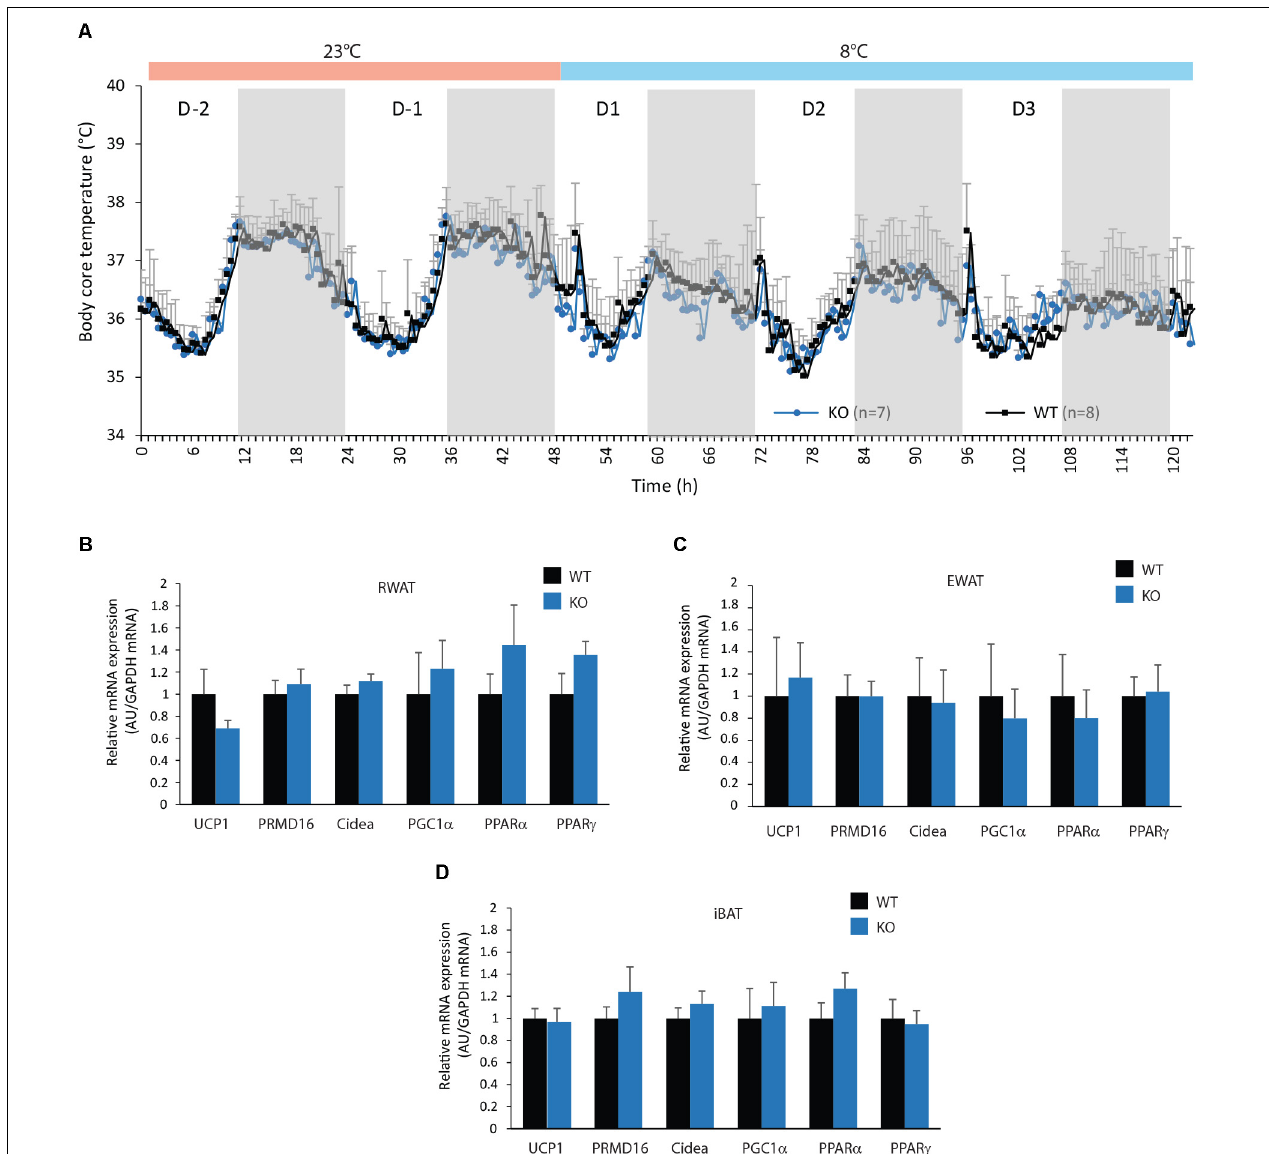
FIGURE 9 | Figure mPGES-1 invalidation does not increase adipocytes browning. (A) Monitoring of body core temperature ( ◦ C) of WT and KO mice exposed at 23 ◦ C during 2 days and at 8 ◦ C the tree following days. (B) Real-time PCR analysis of UCP 1 and adipocytes differentiation related genes in the EWAT (B) , RWAT (C) , and iBAT (D) in WT and KO mice exposed to cold. Data shown are mean ±